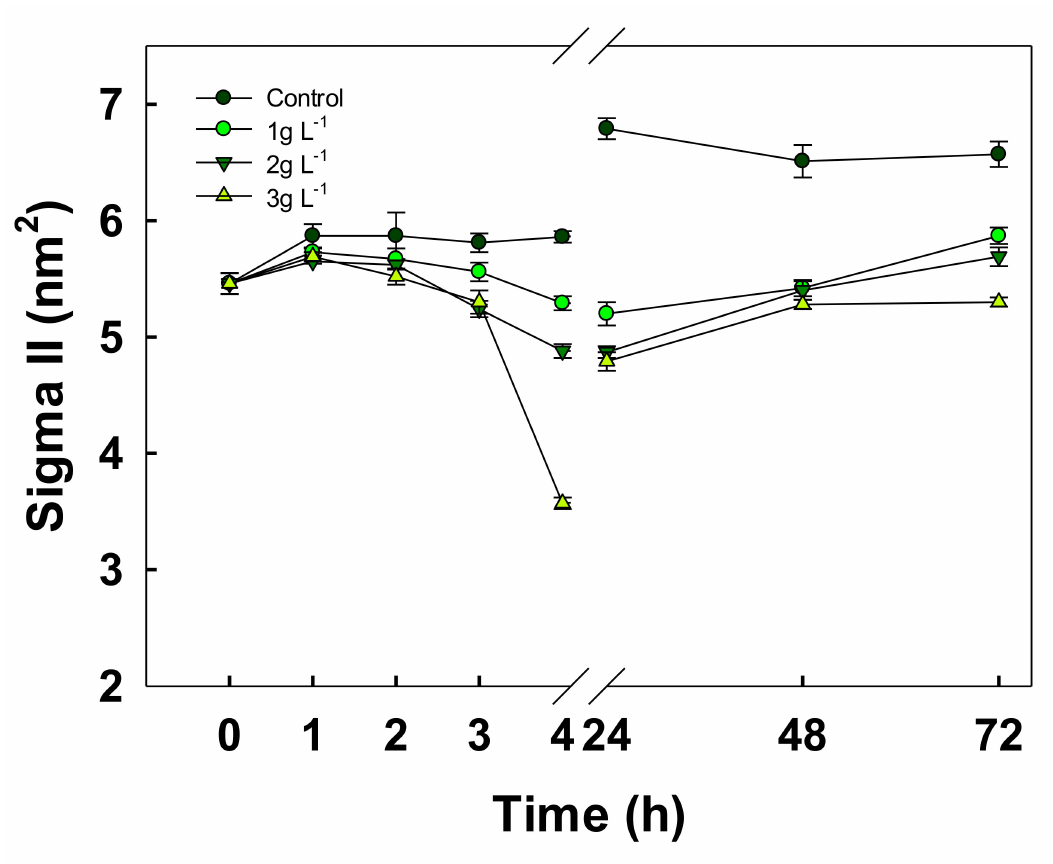
Figure 6. Maximum photosystem II (PSII) e ff ective absorption (440 nm) cross-section ( σ PSII) in Chlorella sorokiniana control cells and in cells grown in bicarbonate 1 g L − 1 , 2 g L − 1 , and 3 g L − 1 enriched medium. Error bars represent SD (n =